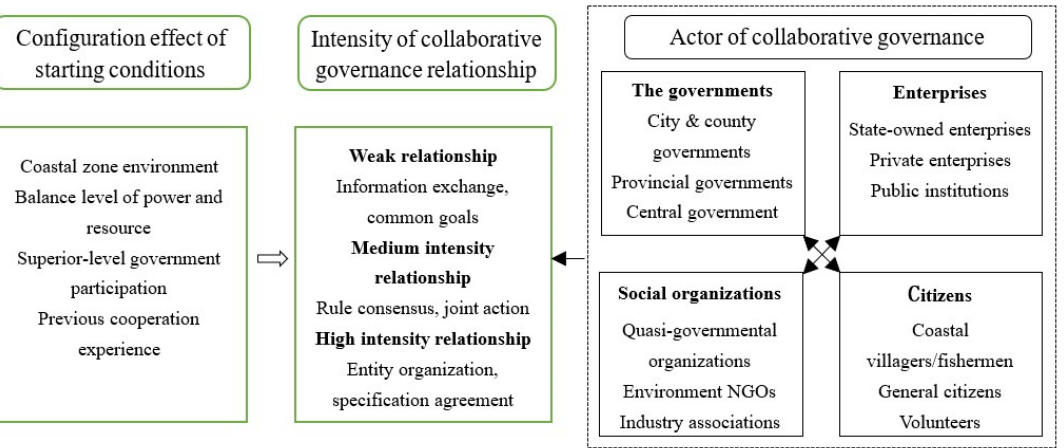
Figure 1. Theoretical framework. Note: “ → ” represents the connections between various actors of coastal environmental governance and the dashed box denotes the actors in collaborative governance relationships. “ ” represents the process from condition variables to the result variables. The green rounded rectangles represent the stages of the theoretical framework of this paper, and the green rectangles represent the specific content of the green rounded